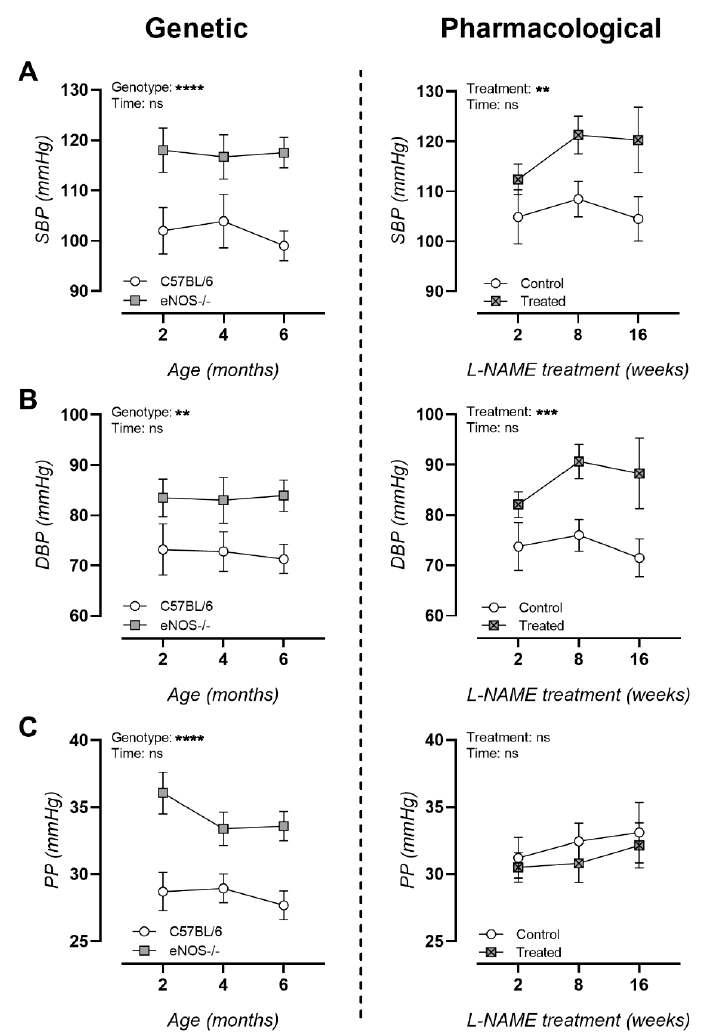
Figure 2. Longitudinal peripheral blood pressure measurements in a genetic and pharmacologically manipulated murine models of NO dysfunction. ( A ) Systolic blood pressure (SBP); ( B ) diastolic blood pressure (DBP) and ( C ) pulse pressure (PP) for genetic (eNOS − / − , left column) and pharmacologically treated (L-NAME, right column) animals. Factorial ANOVA for the factors of genotype/treatment and time; ** p < 0.02, *** p < 0.002, **** p < 0.0002. Data are presented as mean ± SEM.